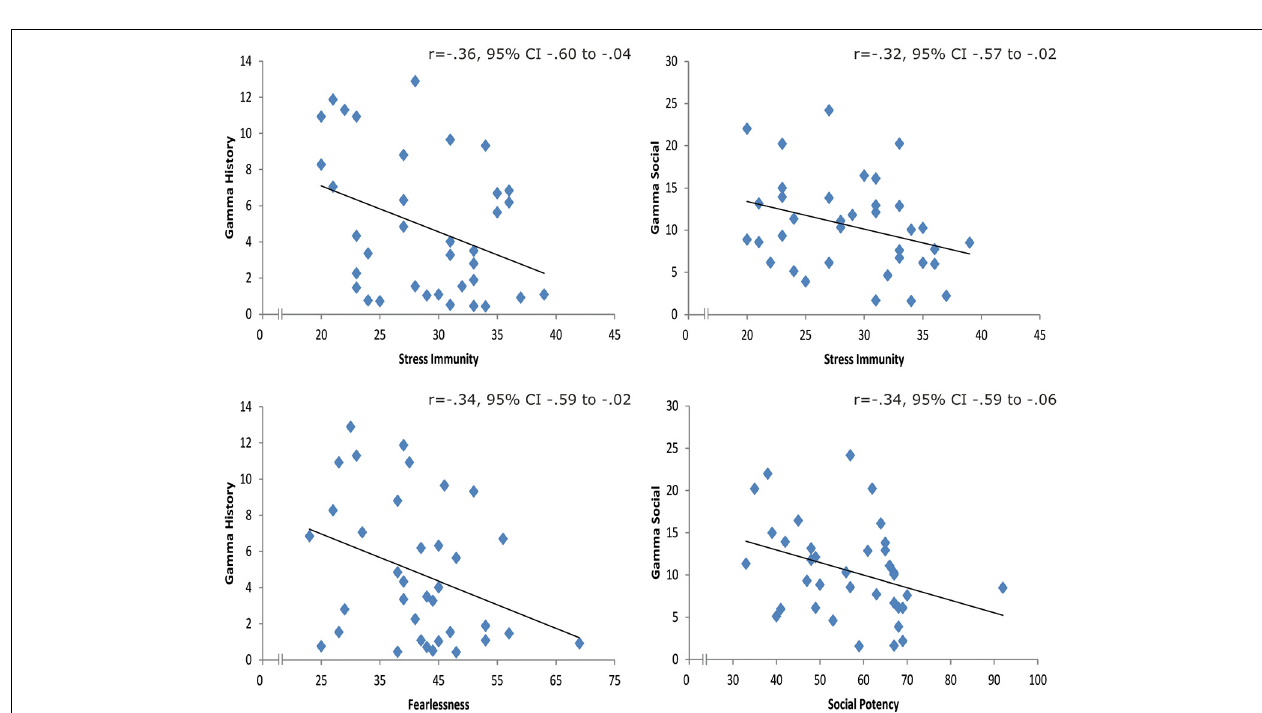
(SSC = 1.0) to left (SSC = 0.0). The variable coefficients (y-axis) are displayed for different stages of shrinkage of the SSC. For each analysis, the variables included in the optimal model (i.e., the model with the lowest expected prediction error) are indicated with the vertical dashed line.